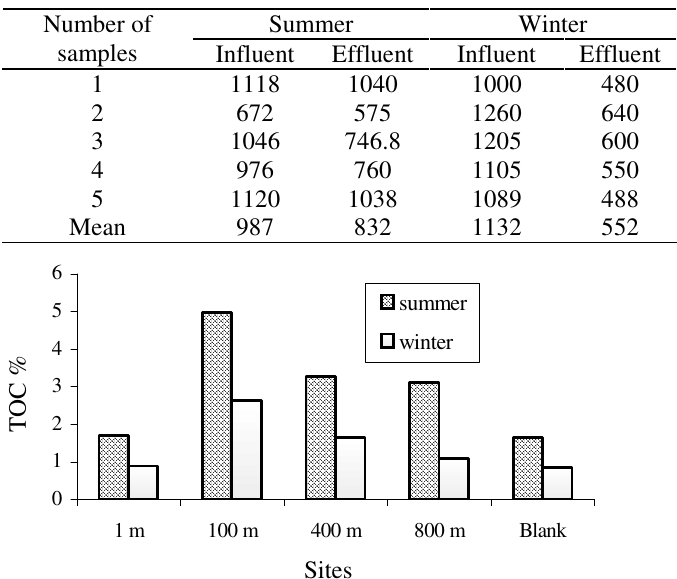
Figure 6. Individual distribution pattern of total organic carbon (TOC %) in sediments for summer and winter seasons in different